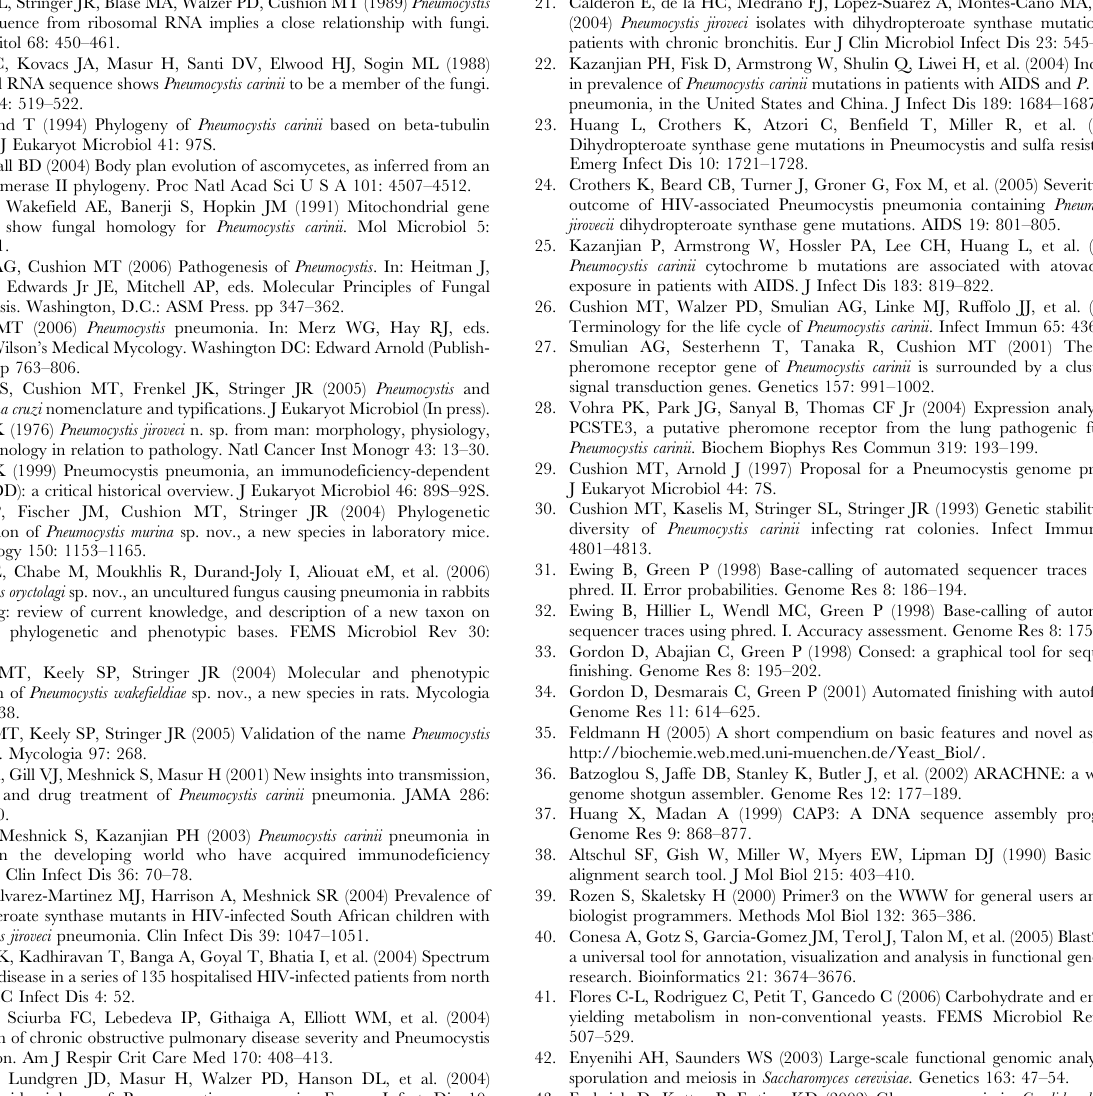
Table S4 Unigene Population of KEGG Pathways Table S5 Orthology List for Unigenes in KEGG